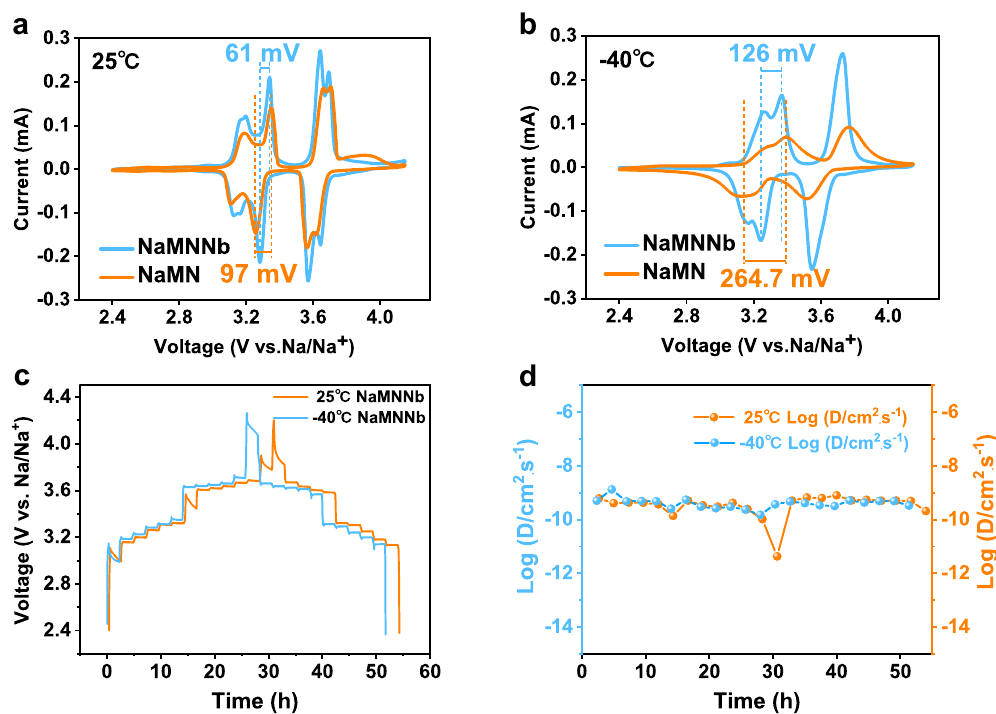
Fig. 3 Electrochemical characterizations of the P2-NaMNNb and P2-NaMN cathode active material at various temperatures. a CV curves of P2- NaMNNb and P2-NaMN at a scan rate of 0.2 mV s − 1 at 25 °C. b CV curves of P2-NaMNNb and P2-NaMN at a scan rate of 0.2 mV s − 1 at − 40 °C. c GITT curves of P2-NaMNNb at 25 °C and − 40 °C. d The corresponding sodium ion diffusion coef fi cient ( D Na + ) of P2-NaMNNb calculated from GITT formula at 25 °C and − 40